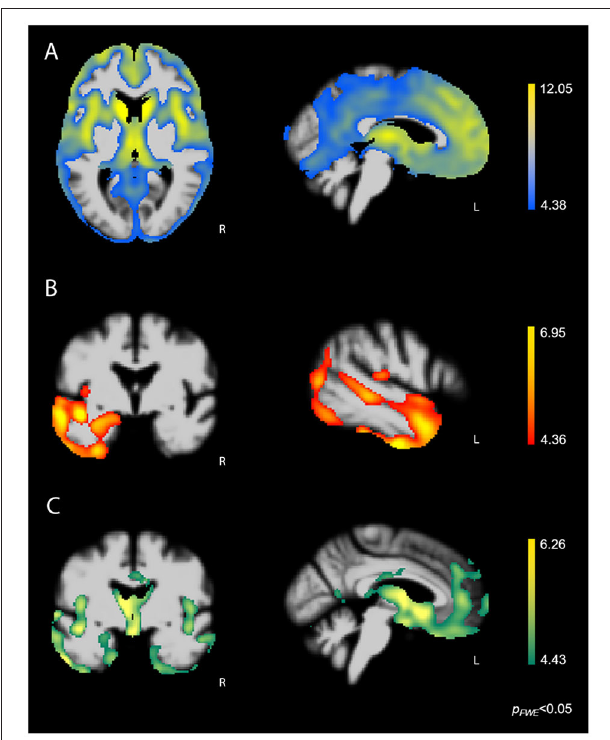
FIGURE 3 | FWE-corrected t -maps showing regions where atrophy predicted SBOCL subscale scores. (A) Higher score on the Disorganized subscale corresponded with lower volume predominantly in bilateral fronto-subcortical regions, including the caudate, thalamus, anterior insula, as well as medial, lateral, and orbitofrontal cortex. (B) Higher score on the Reactive subscale corresponded with gray matter atrophy in the left lateral and mesial temporal lobe. (C) Higher score on the Insensitive subscale corresponded with volume loss in bilateral fronto-temporal and subcortical regions, including the caudate, thalamus, anterior insula, subgenual ACC, OFC, as well as medial and lateral temporal lobe. Age, sex, and TIV were included as covariates of no interest in each analysis. L,